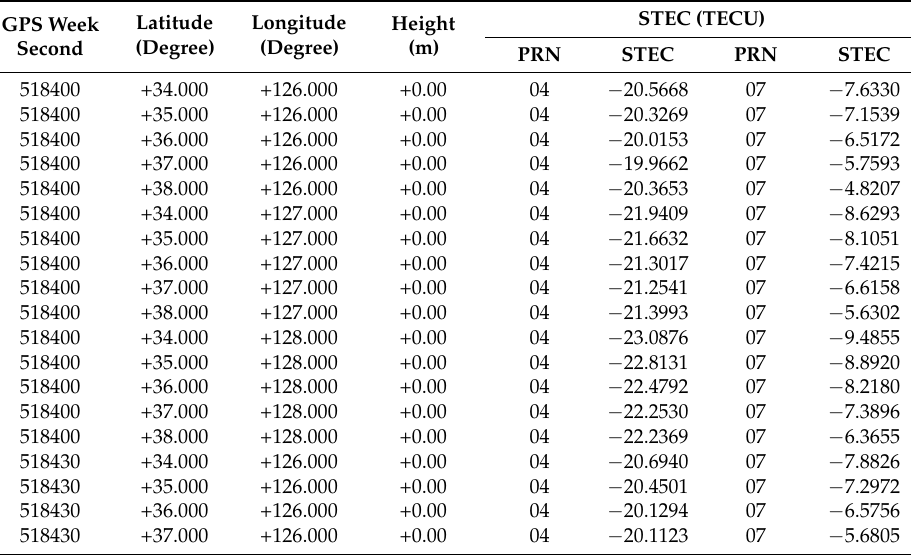
Table A4. Sample ionospheric corrections provided by SSR